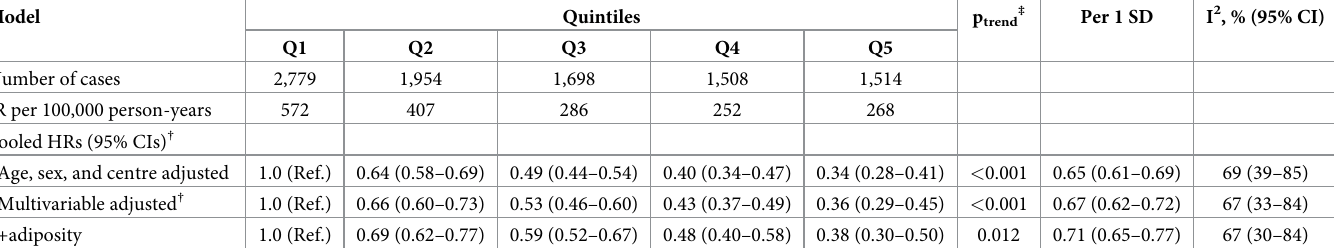
Table 2. Associations between the nutritional biomarker score of the Mediterranean diet * with incidence of T2D in the European Prospective Investigation into Cancer and Nutrition-InterAct ( n = 22,202).